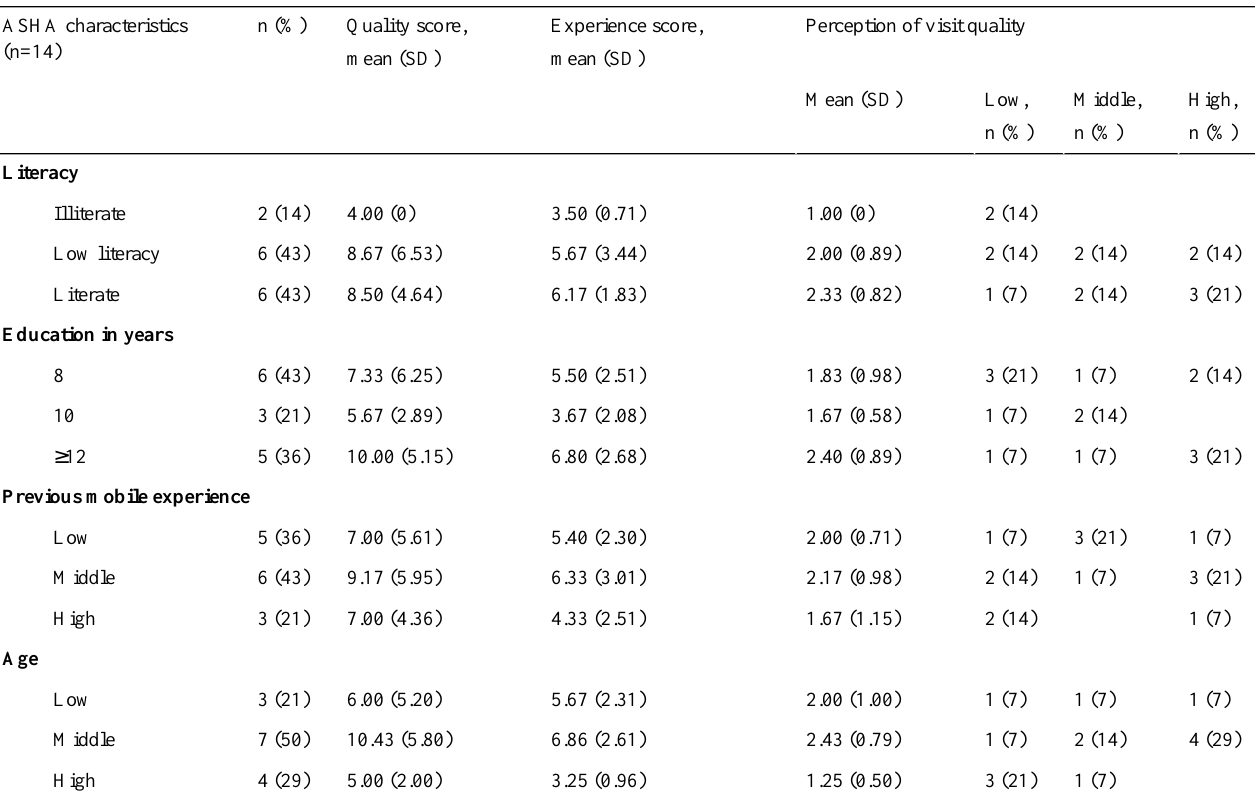
Table 5. Quality and experience scores by ASHA individual characteristics.